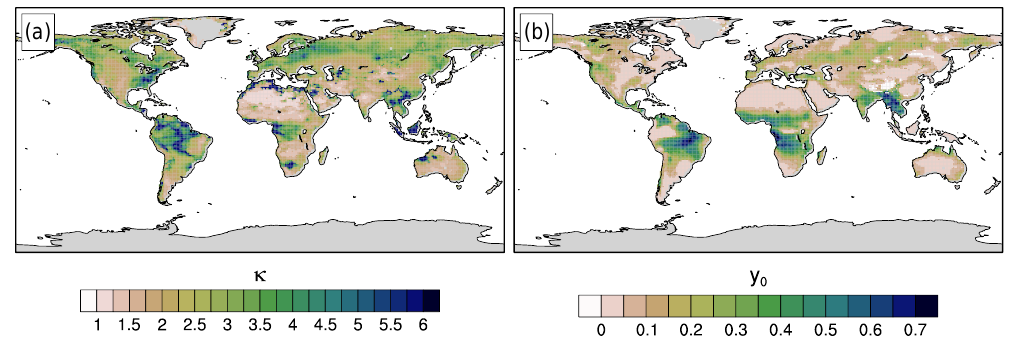
Figure 7. Estimated values of κ (a) and y 0 (b) estimated in a least squares fitting using standard monthly datasets of P , E and E p within the 1990–2000 period.